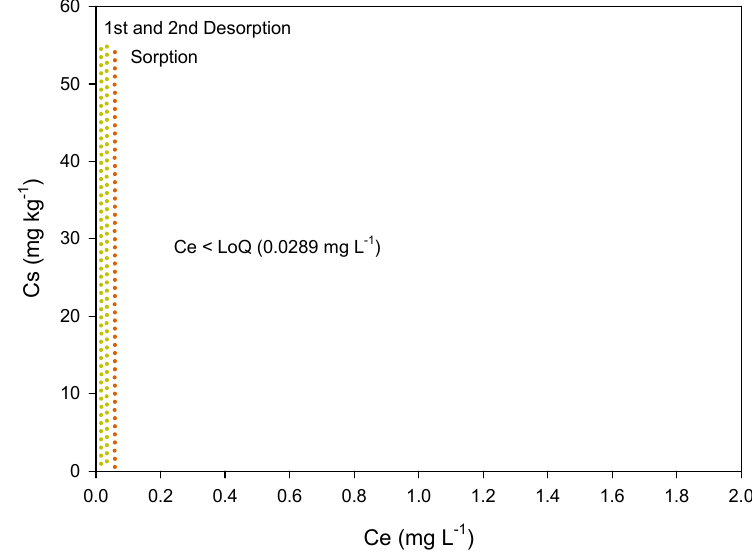
Figure 3. Sorption and desorption isotherms of metribuzin in pure bonechar powder (2 g) added in water. The x-axis indicates the Ce concentration at equilibrium, and the y-axis indicates the Cs concentration in the sorbent. Dotted lines show that no residues of the herbicide were detected (<limit of quantification (LoQ)). One-hundred percent sorption and 0% desorption of the herbicide were observed in the pure bonechar powder.